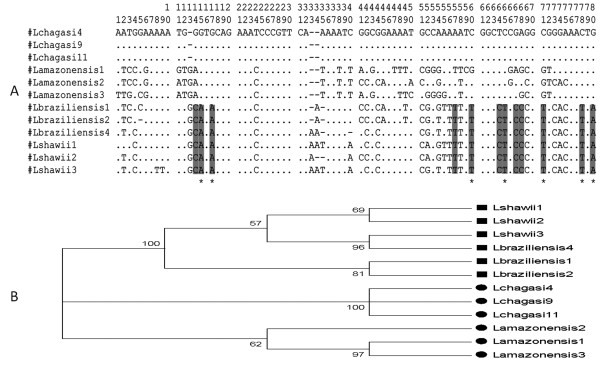
Sequence alignment of amplified minicircles kDNA conserved region and phylogenetic analysis. A - Alignment of 12 generated sequences representing three clones for each analyzed Leishmania reference strain. Highlighted in gray: Exclusively L. (Viannia) subgenus conserved nucleotides. Most of the substitutions shown are possibly associated with the lower melting temperature (Tm) characteristic for this subgenus (indicated by asterisks). B - Neighbor-Joining tree based on kDNA amplicons sequence. The rectangles represent sequences from subgenus Viannia and circles indicate those from subgenus Leishmania. Bootstraps values are indicated.